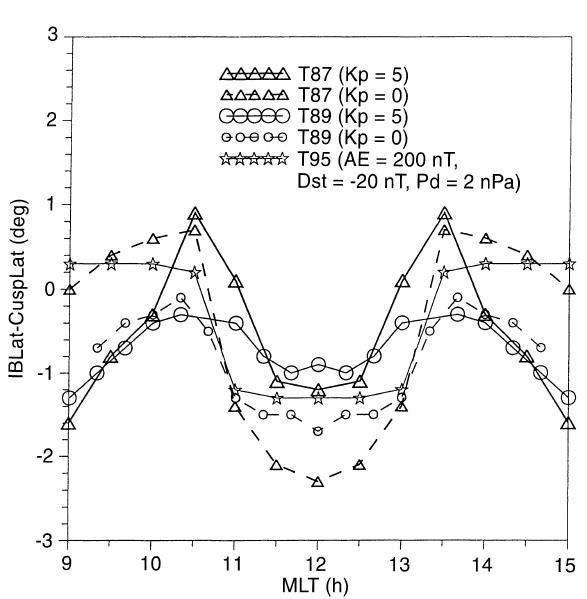
Fig. 4. Shape of dayside isotropic boundary in di(cid:128)erent models for zero dipole tilt. To facilitate the comparison, all profiles are shifted in latitude so that last close field line has a zero latitude